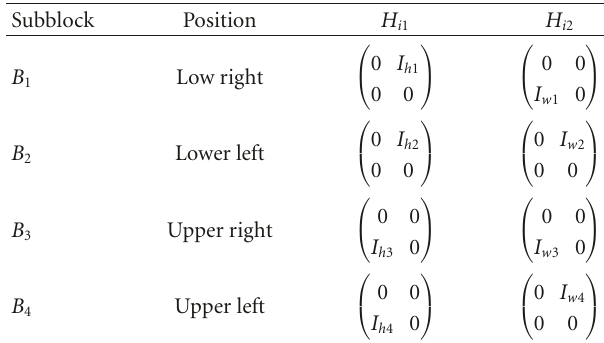
Figure 5: A new image block, B (cid:2) , consisting of contributions ( B (cid:2) 1 , B (cid:2) 2 , B (cid:2) 3 , and B (cid:2) 4 ) from four original neighboring blocks ( B 1 , B 2 , B 3 , and B 4 ). Table 2: Matrices of H i 1 and H i 2